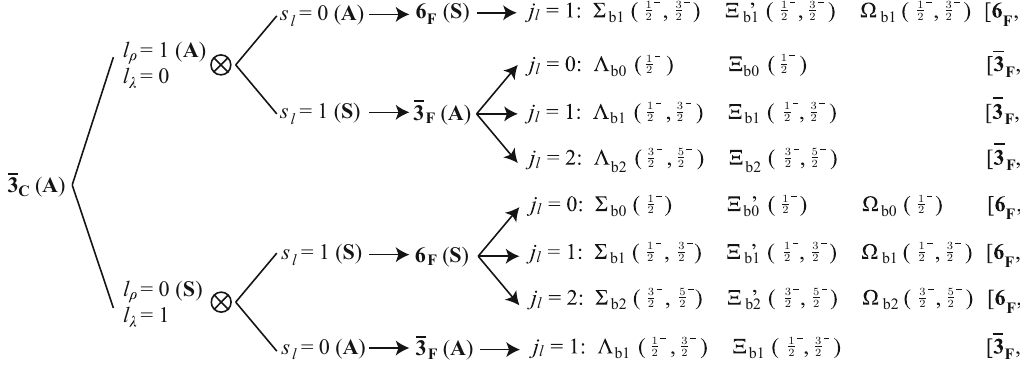
Fig. 1 Categorization of P -wave bottom baryons. Taken from Ref.